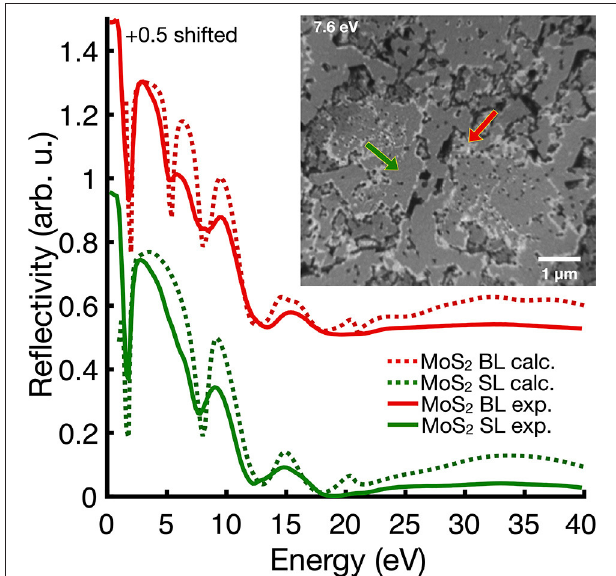
FIGURE 5 | I(V)-LEEM dataset of two MoS 2 regions in the corresponding LEEM image (see inset). The gray region (green arrow and line) is identified as single-layer MoS 2 and the white region (red arrow and line) as bilayer MoS 2 (shifted by +0.5, for clarity). The calculated reflectivity curves of single and bilayer MoS 2 as reported by de Jong etal. [29] are plotted in dashed lines and prove the